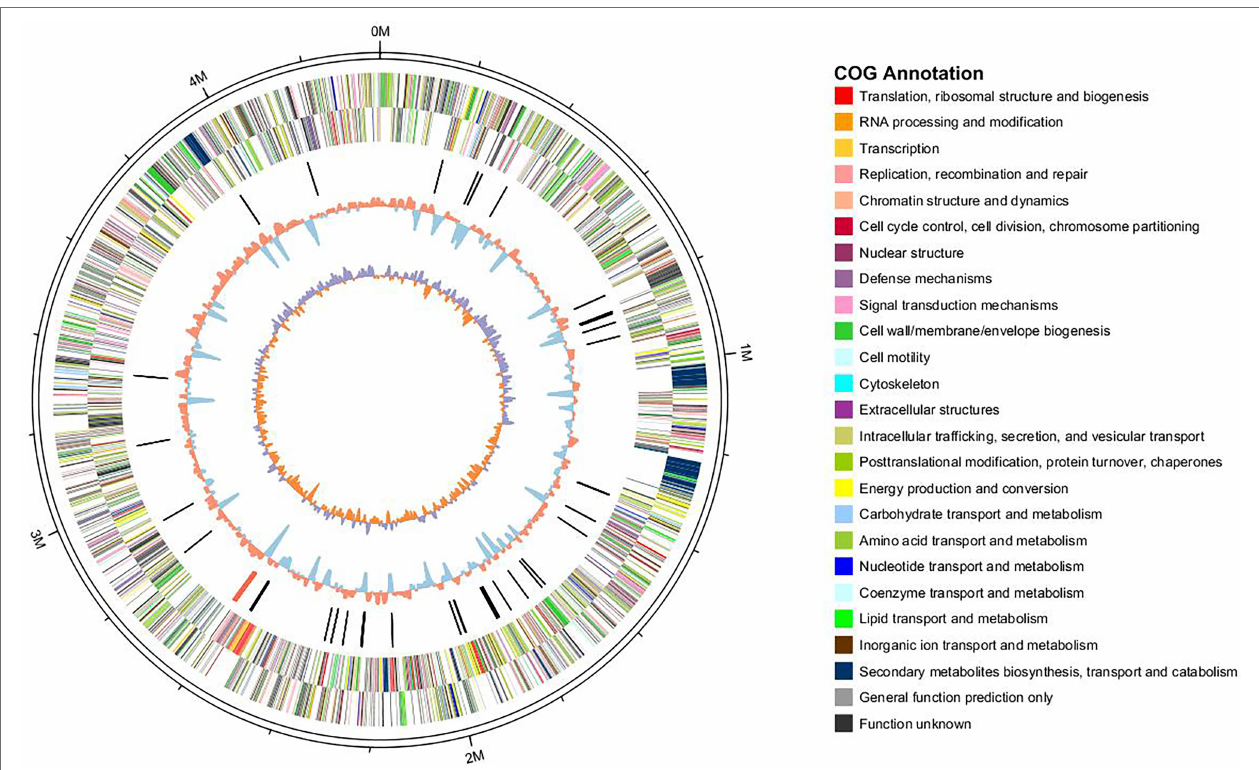
FIGURE 5 | Circle graph of the Lysobacter brunescens YQ20 chromosome. Circles are numbered from 1 (outer) to 5 (inner). Circles 1–2, locations of predicted CDSs on + and − strands, respectively; Circle 3, nonprotein coding RNA (ncRNA); Circle 4, %G + C content; Circle 5, GC skew = (G − C)/(G +